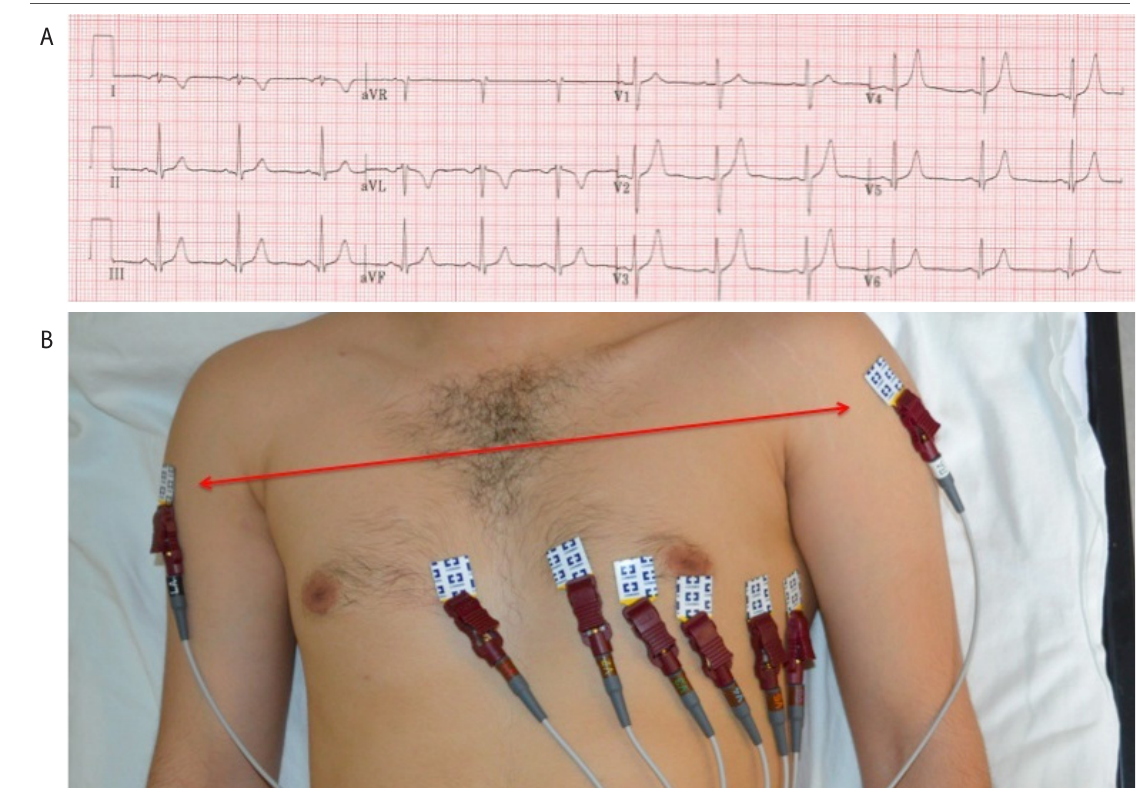
Figure 2. 12 lead ECG depicting left arm and right arm reversal. (A) ECG recording. (B) Arrows point to reversal of leads on left arm and right